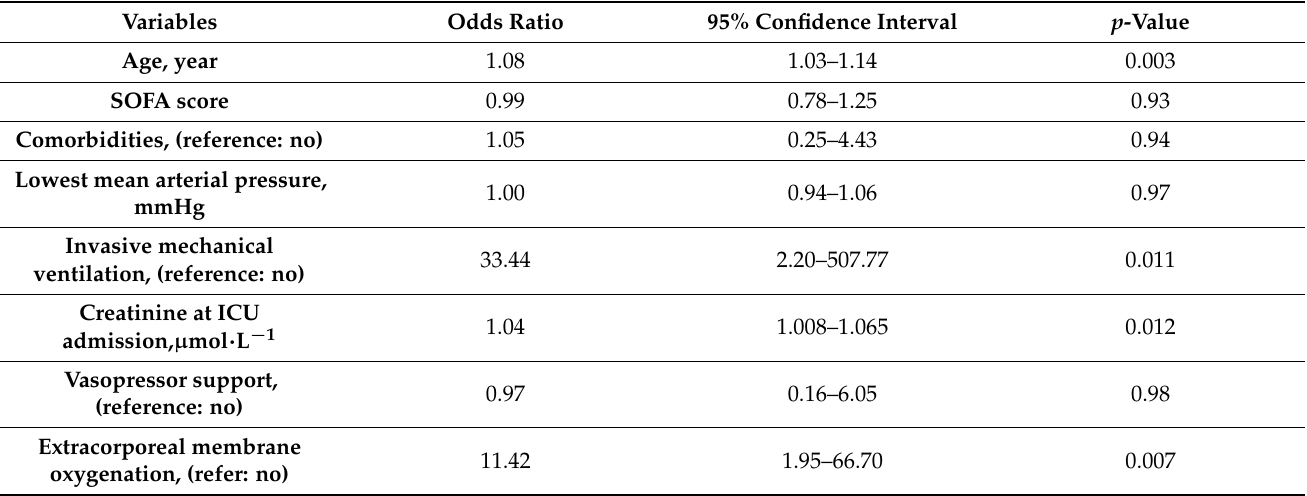
Table 2. Factors associated with severe AKI (stages 2 and 3) in multivariable logistic regression analysis.